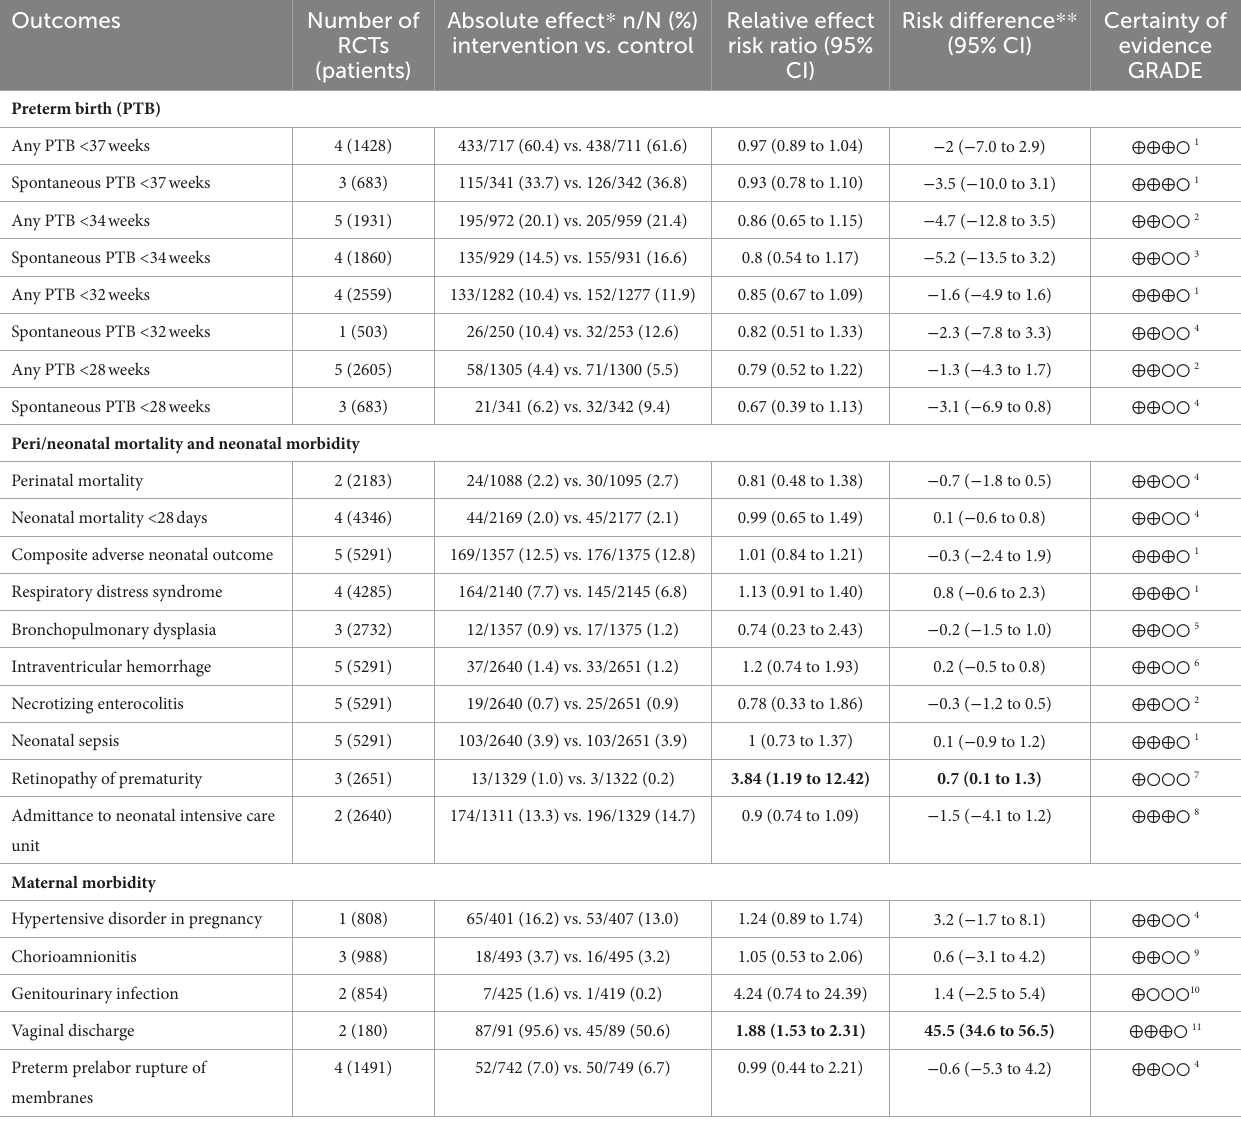
TABLE 8 Summary of findings for main outcomes (based on trials with low risk of bias): Pessary vs no pessary in women with a multifetal pregnancy with or without additional risk factor(s) for preterm